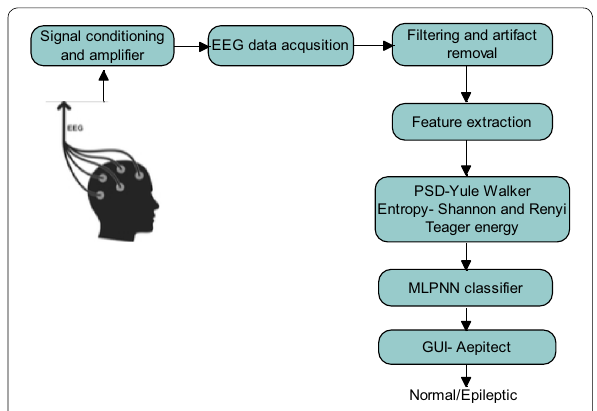
Fig. 1 Block diagram of the proposed Aepitect